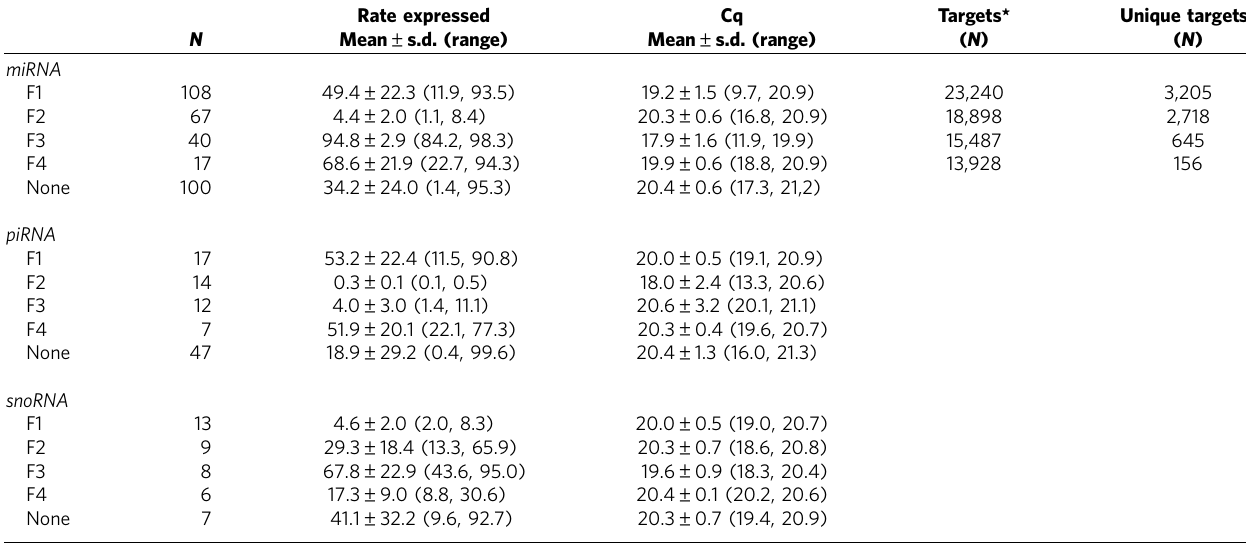
score calculated from an individual’s age, sex, diabetes status, smoking status, treated or untreated systolic blood pressure and lipid levels (Fig.